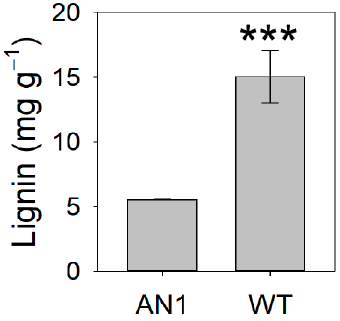
Figure 6. Microscopy images of the adaxial side of ( A ) AN1 and ( B ) WT leaves (20×).